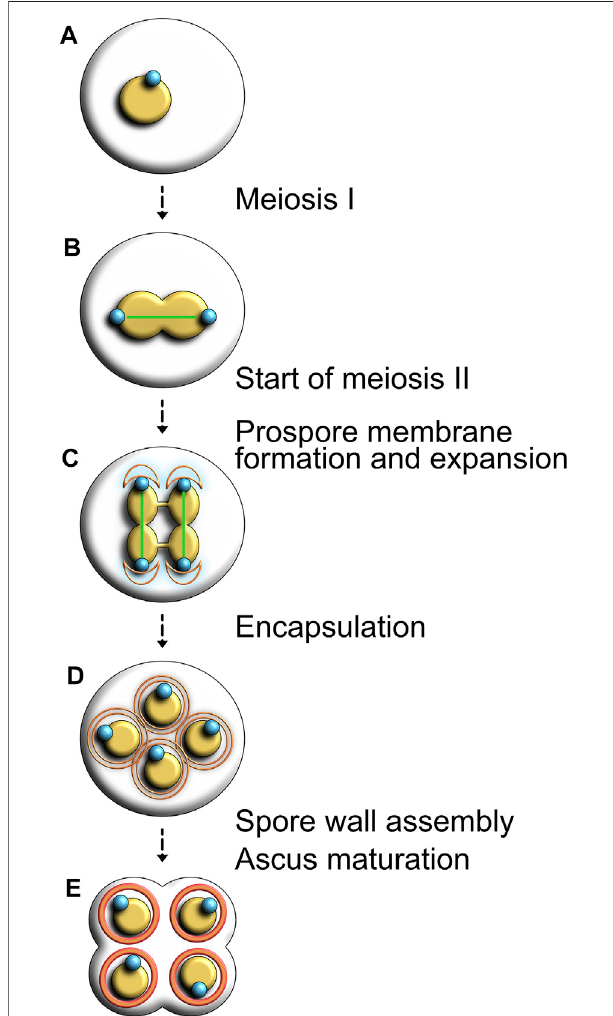
FIGURE 6 | Visual representation of sporulation and ascus formation in budding yeast. (A) In response to environmental stressors, diploid yeast cells initiate the sporulation program. (B) Completion of meiosis I nuclear division. (C) After the second round of chromosome segregation, the prospore membrane (shown in orange) forms and expands around each duplicated SPB (shown in blue). (D) The membrane grows and encapsulates each haploid nucleus in the tetrad. (E) Spore wall assembly begins and the remnants of the mother cell breaks down.